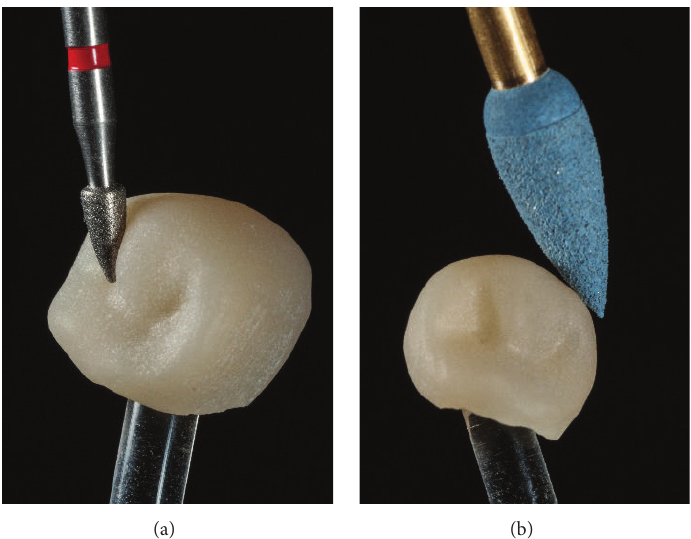
Figure 7: Postprocessing of the occlusal surface and prepolishing using a diamond-impregnated polyurethane